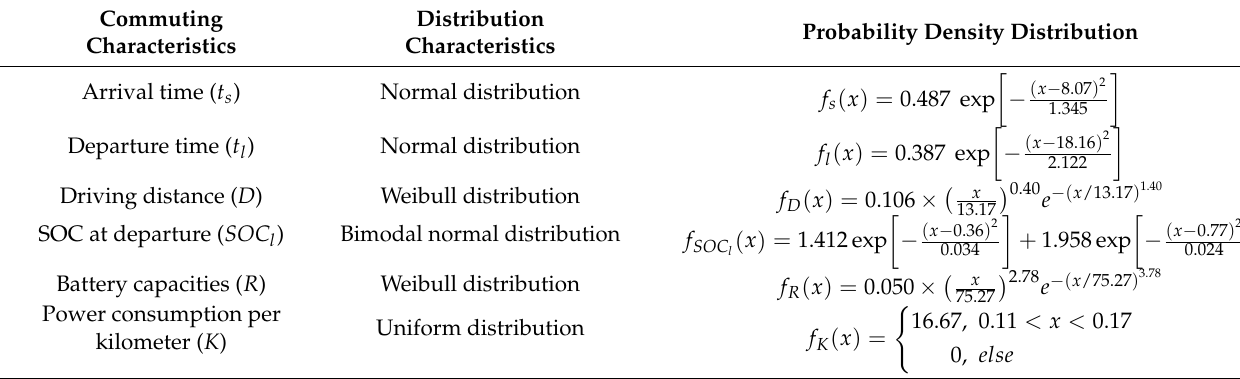
Table 2. Probability density distributions of commuting